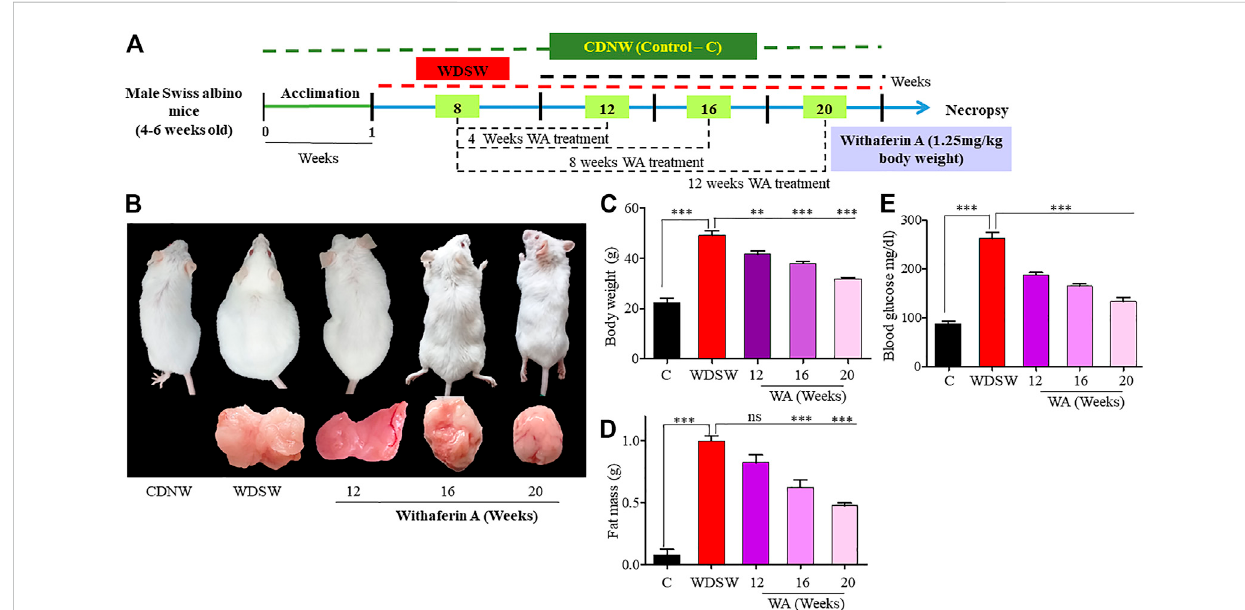
Withaferin A(WA) inhibited diet-induced obesity. (A) Experimentaltreatment patternfortesting thetherapeuticeffectsofWAintheWDSW-induced NAFLD mouse model. (B) Images represent the reduction in body and adipose tissue weights in a withaferin A-treated WDSW-induced NAFLD mouse model. (C,D) GraphicalrepresentationdepictingthedecreaseinbodyandadiposetissueweightsinwithaferinA-treated groupsatdifferenttimeintervals compared to the WDSW group. (E) Serum glucose levels. Data are expressed as mean ± SEM for six animals per